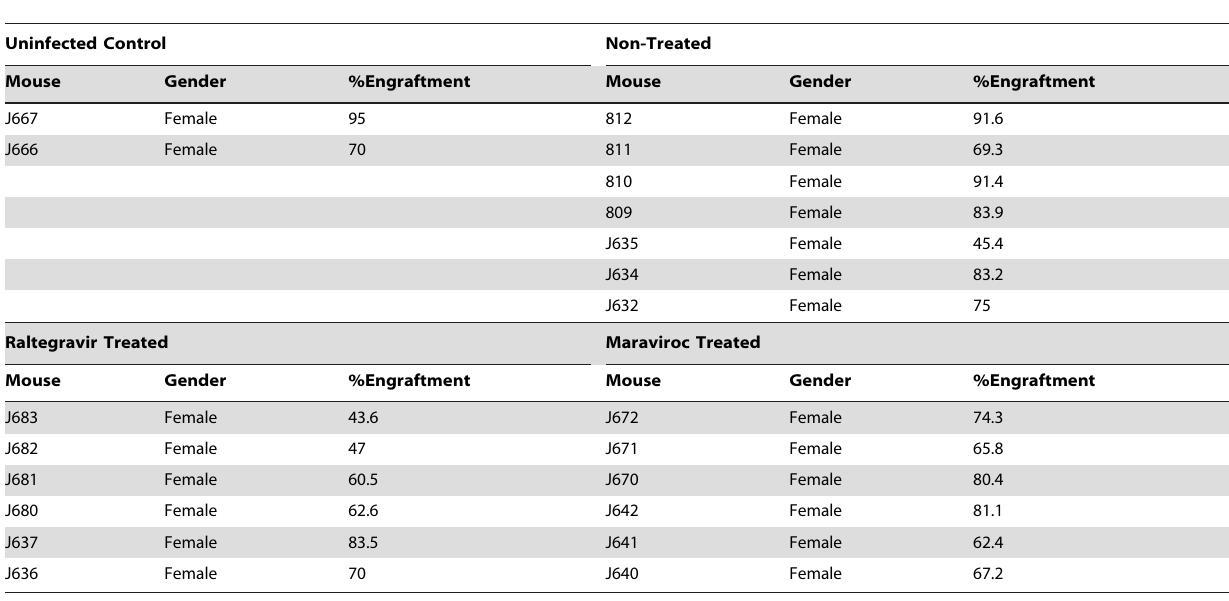
Table 1. Summary of human cell engraftment levels in humanized (RAG-hu) mice*.